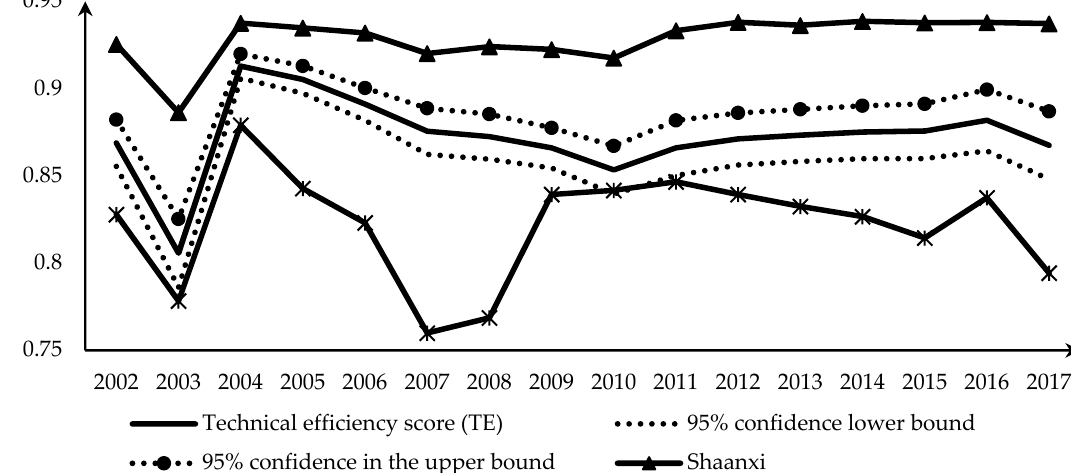
Figure 2. Agricultural TE scores from 2002 to 2017.